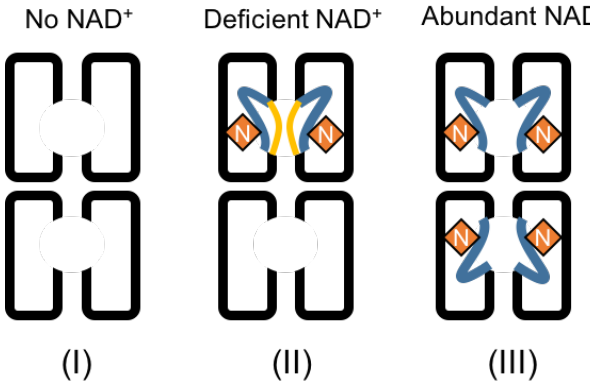
Figure 4. A model of the conformational dynamics in DHS, regulated by NAD + . Three binding conformations are shown. On the left, the spermidine binding loop is disordered when there is no NAD + binding to DHS. In the middle, the loop is partially stabilized and structured in either conf1 or conf2 when NAD + binds to DHS. The binding of one NAD + to DHS could promote a second NAD + to bind to another monomer of the dimer, and binding of both NAD + s would be stabilized via the formation of the hydrogen bond between them. The spermidine binding loop is still disordered in another dimer of the tetramer which remains NAD + -free. On the right, the spermidine binding loop of all four monomers of Pho DHS will be ordered in conf2 in the presence of abundant NAD + , based on the current structure and human DHS structure. Yellow lines: loop in conf1 away from NAD + ; blue lines: loop in conf2 towards NAD + ; N: NAD + molecules.